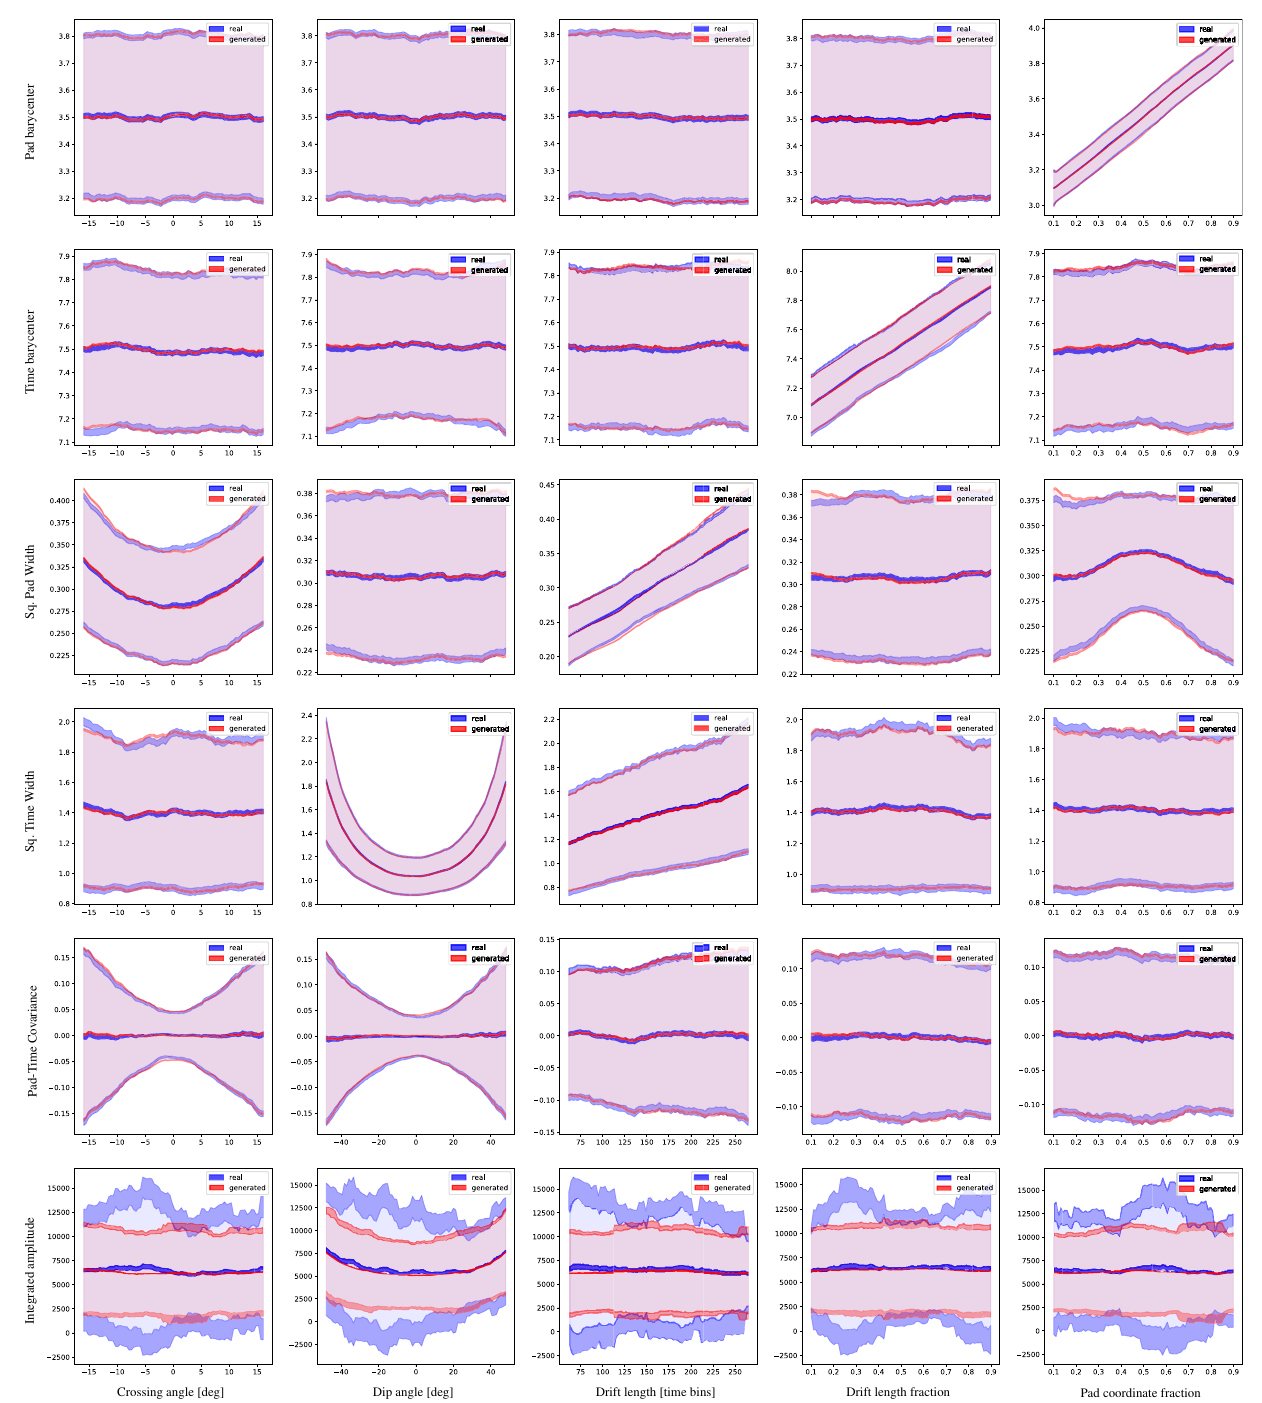
Fig. 3 Profiles of the validation metric distributions as the function of the input variables. For each metric ξ , we show its average value μ ξ (middle thick line), as well as the average shifted up and down by a standard deviation of the metric distribution μ ξ ± σ ξ (top and bot-